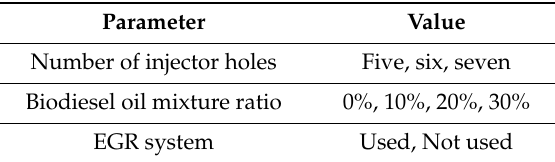
Table 5. Experimental